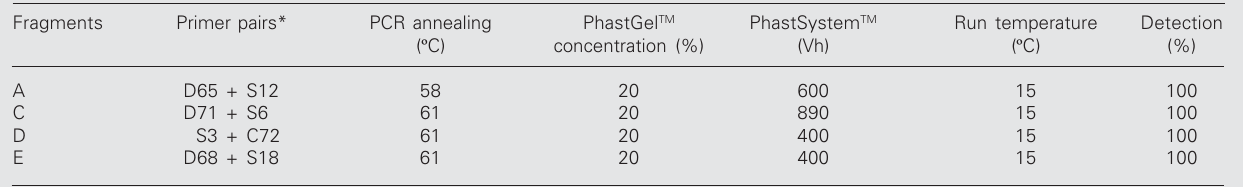
*Primer sequences are described in Figure